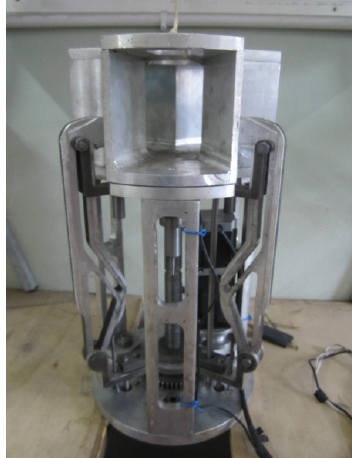
Figure 10 . Docking mechanism prototype .